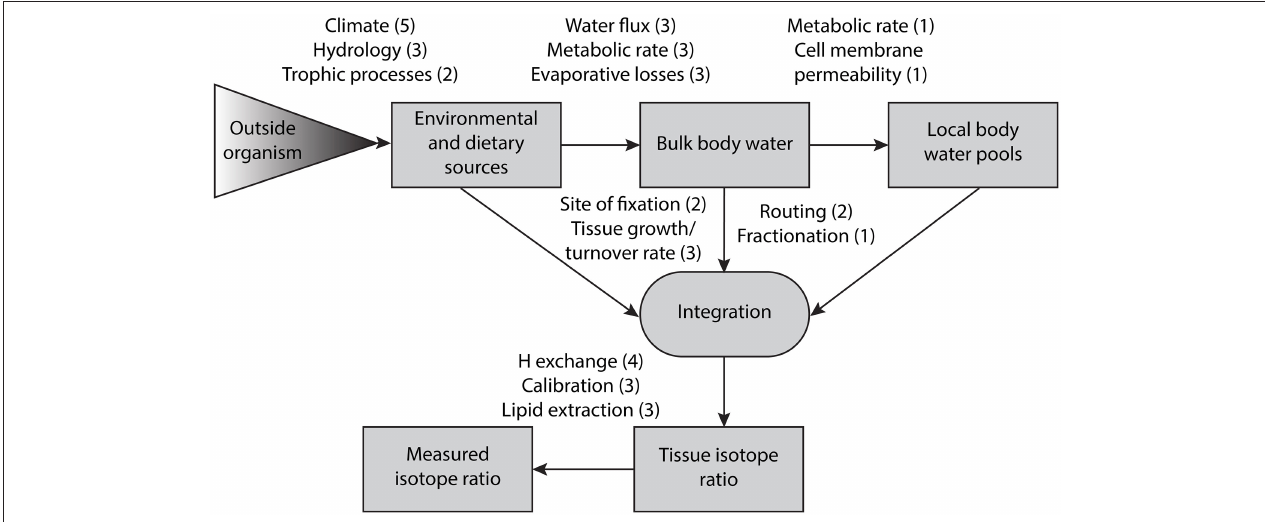
FIGURE 1 | This conceptual diagram summarizes the processes that influence δ 2 H and δ 18 O integration from environmental (water and molecular O 2 ) and dietary sources into animal tissues. Boxed text indicates stages of integration and analytical measurement, whereas unboxed text indicates factors that can affect δ 2 H and δ 18 O values between these stages. The shaded triangle refers to processes that affect environmental and dietary sources prior to entering the organism. The number in parentheses after each factor indicates a level of understanding ranging from 1 (minimal understanding) to 5 (well-characterized). The four factors related to integration (site of fixation, tissue growth/turnover rate, routing, and fractionation) are relevant to all incoming sources (environmental and dietary sources, bulk body water, and local body water pools).